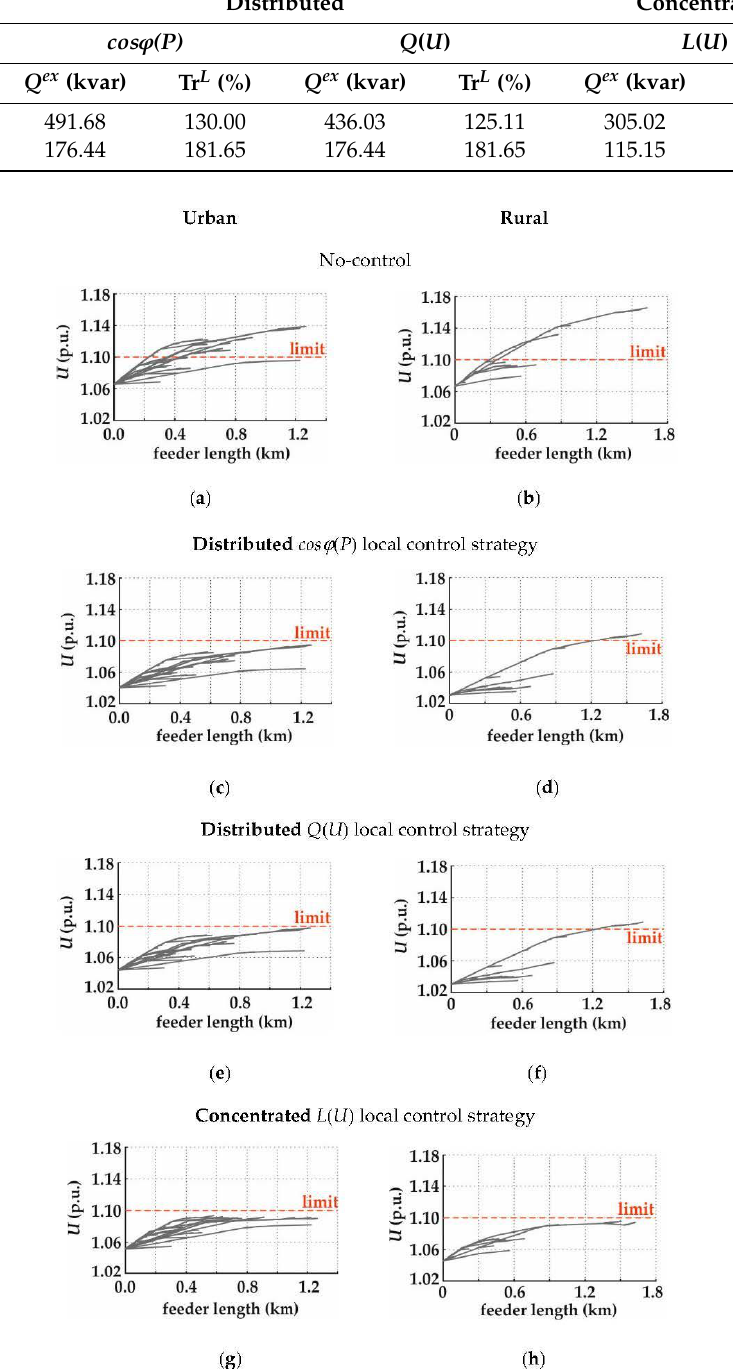
Figure 20. Overview of voltage profiles of two typical real grids, urban and rural, when no-control, distributed cos ϕ ( P ), distributed Q ( U ), and concentrated L ( U ) local control strategies are